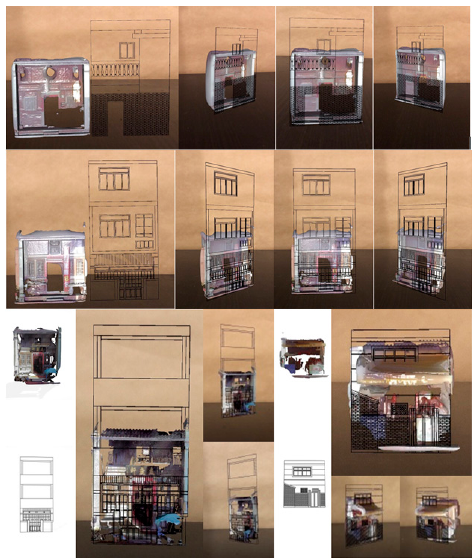
Figure 12. AR comparisons of the booth, material, and composition of façades on the two streets in a laboratory setting, using a mesh model and a wireframe-like mesh model. The top , middle , and two bottom images represent four cases of comparisons.